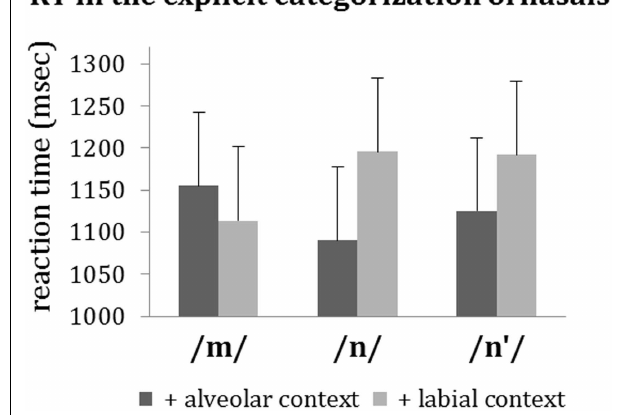
FIGURE 2 | Reaction times (and standard errors) in the two-alternative (N or M) forced-choice categorizations task.